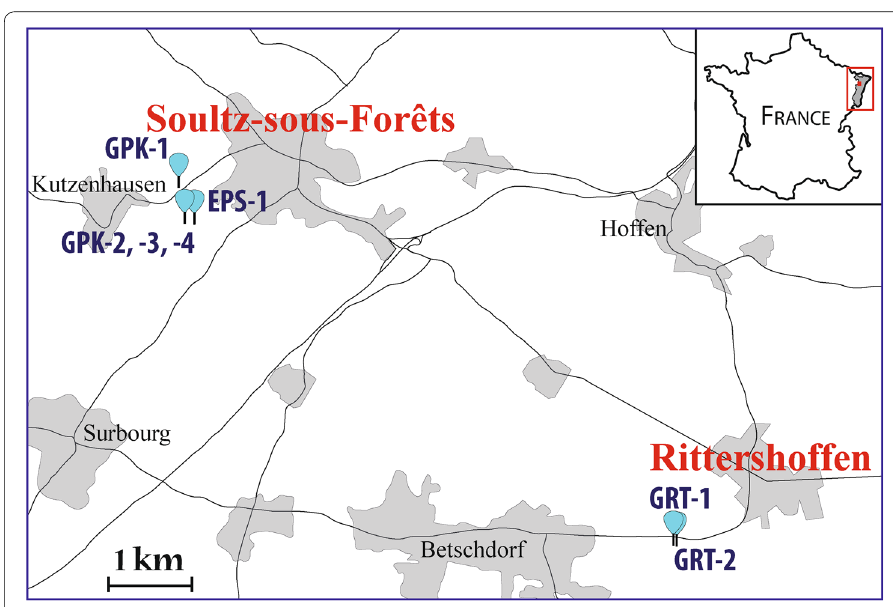
Fig. 1 Location of wellheads of EPS-1 exploration well, the GPK-1, GPK-2, GPK-3 and GPK-4 geothermal wells at Soultz-sous-Forêts and GRT-1 and GRT-2 at Rittershoffen. It is located in the French north-western part of the Upper Rhine